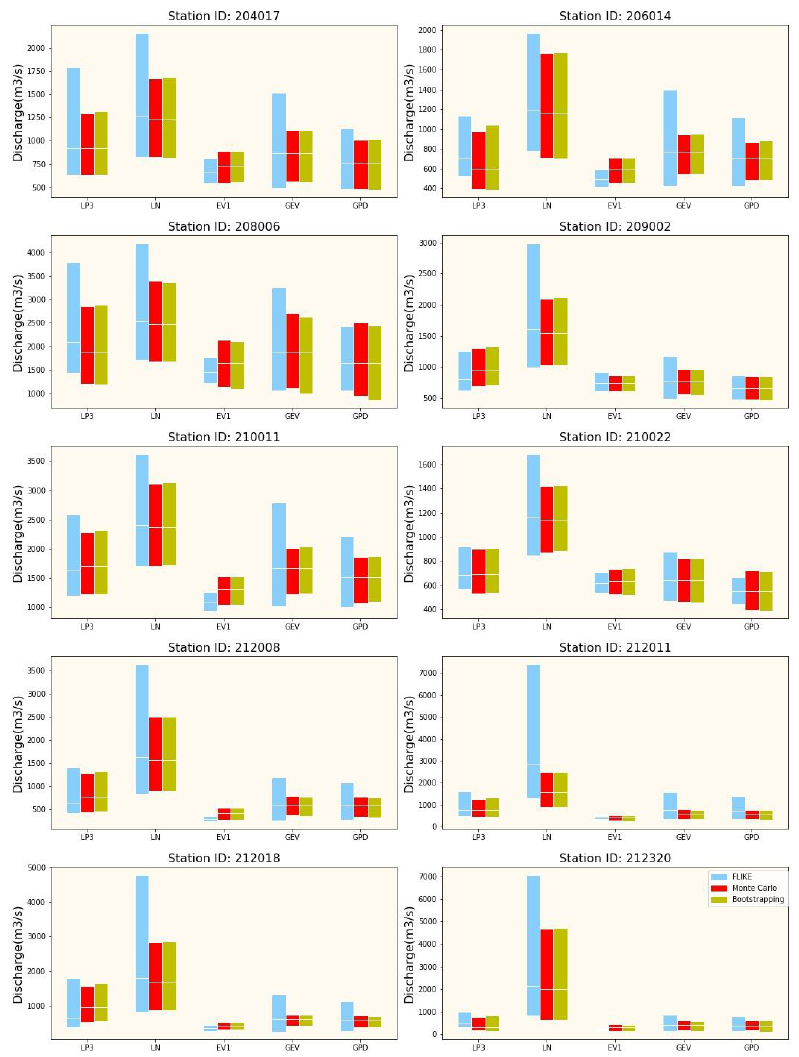
Figure 8. Flood discharge for upper confidence band at ARI of 100 years (1% AEP) determined from BS, MCST, and FLIKE.